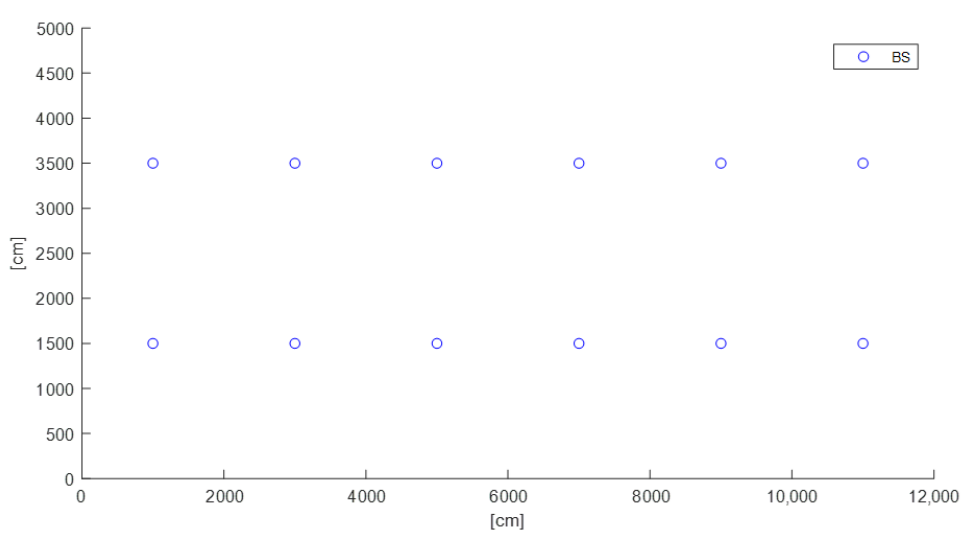
Figure 5. Location of Wi-Fi AP in indoor office environment.